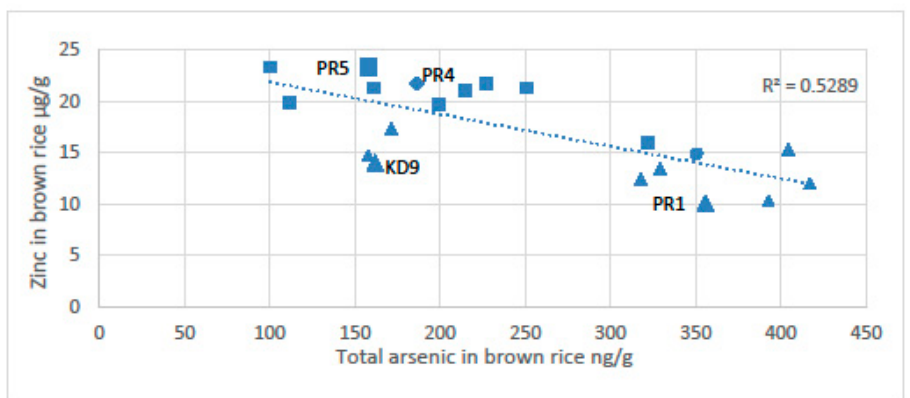
Figure 7. Total arsenic vs. total zinc in brown rice composite samples. [12]. Squares represent farms with cows and triangles represent farms without cows. Samples represented by the larger- sized symbols (Preak Russey-1, KD-9 and Preak Russey-5) were collected with a fixed grid of nine subsamples. The diamond represents Preak Russey-4, which had a treatment ditch.Abbreviations: Kd9, Kandal-9 farm; PR5, Preak Russey-5 farm; PR4, Preak Russey-4 farm; PR1, Preak Russey-1 farm.